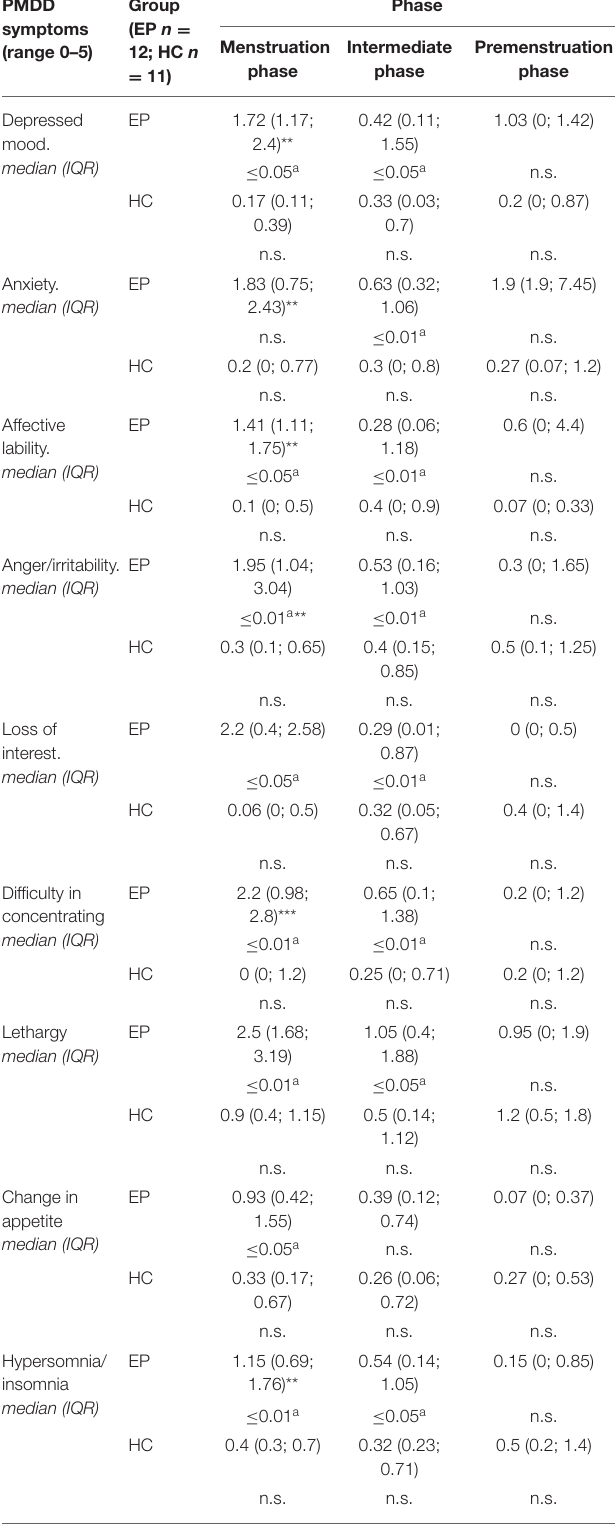
TABLE 3 | Diary results for PMDD symptoms in endometriosis patients and healthy controls, according to cycle phases. PMDD symptoms